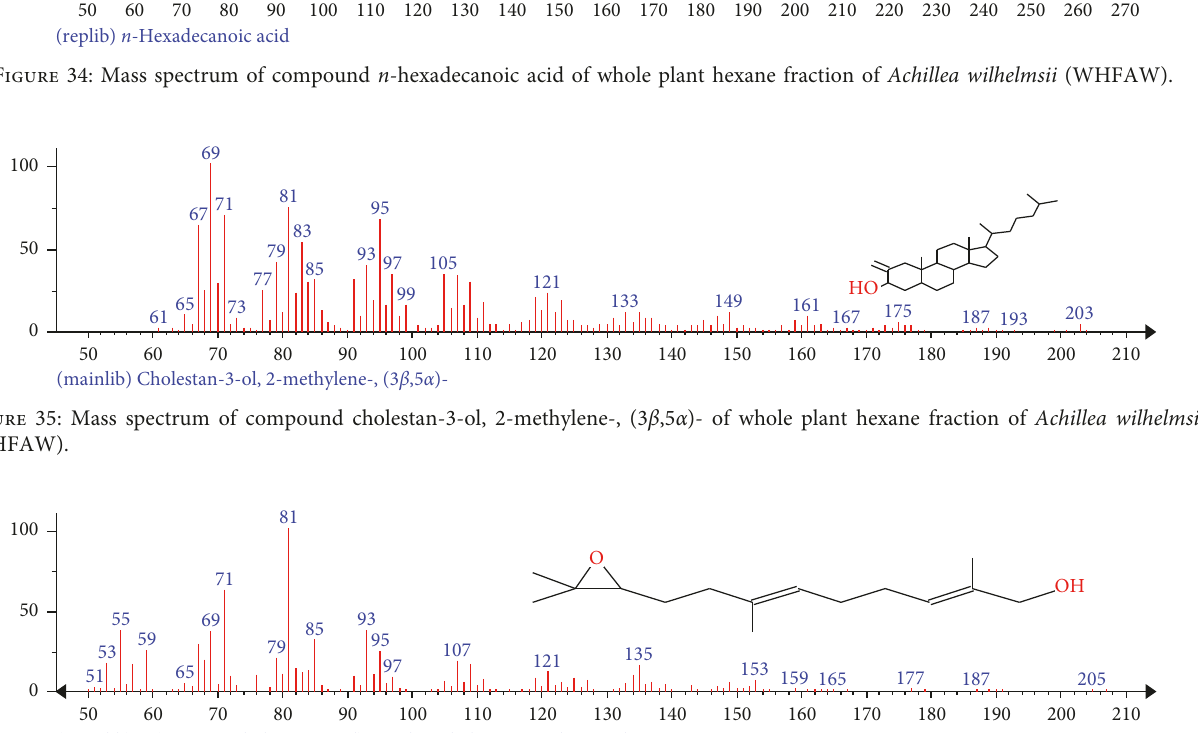
9-(3,3-Dimethyloxiran-2-yl)-2,7-dimethylnona-2,6-dien-1-ol50 60 (mainlib) Figure 36: Mass spectrum of compound 9-(3,3-dimethyloxiran-2-yl)-2,7-dimethylnona-2,6-dien-1-ol of whole plant hexane fraction of Achillea wilhelmsii (WHFAW).